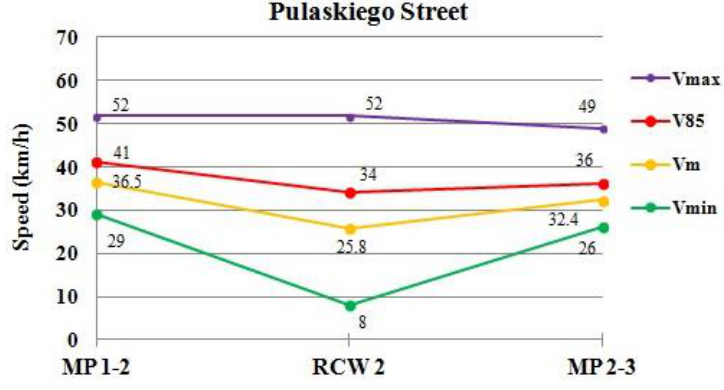
Figure 6. Speed values in the measurement points in Pulaskiego Street, in Bialystok (Poland).